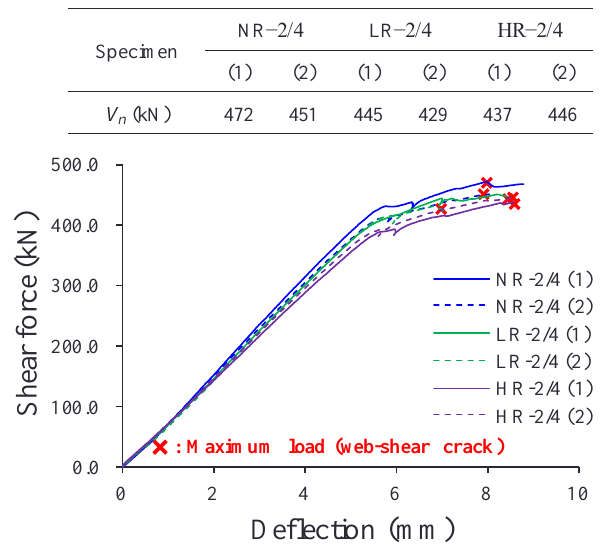
Figure 8. Effect of helix shear reinforcement on shear strength.